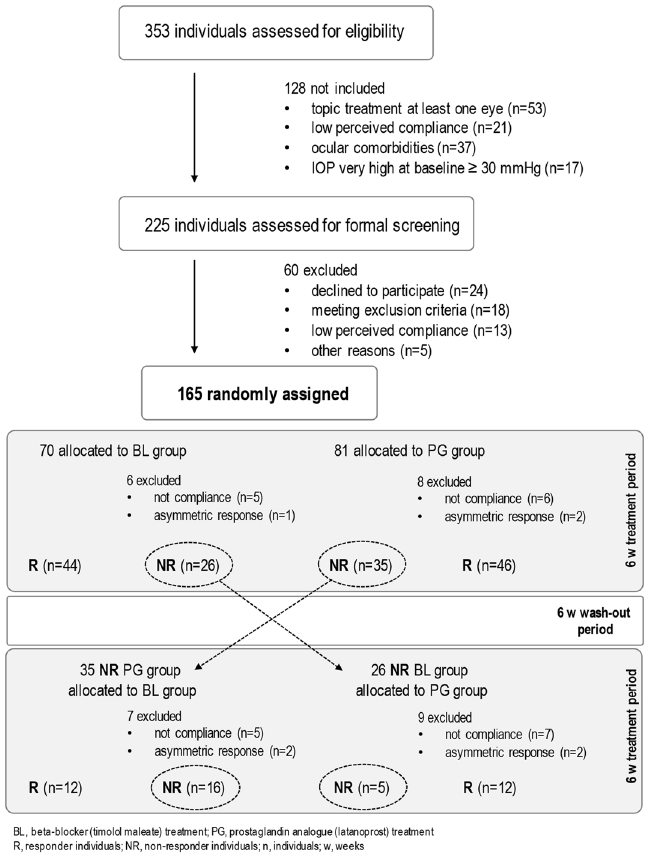
Figure 1. Study flowchart, design and